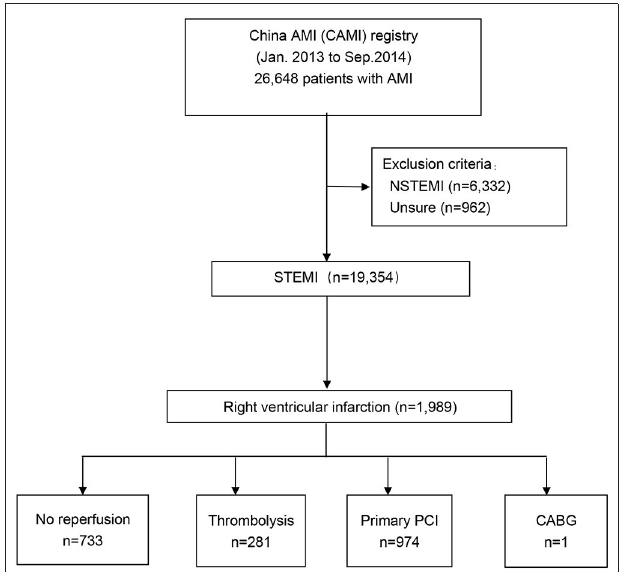
FIGURE 1 | Study flow. The study population was derived from the nationwide, multicenter, prospective China Acute Myocardial Infarction (CAMI) Registry. CABG, coronary artery bypass graft; NSTEMI, non–ST-segment elevation myocardial infarction; PCI, percutaneous coronary intervention; STEMI, ST-segment elevation myocardial